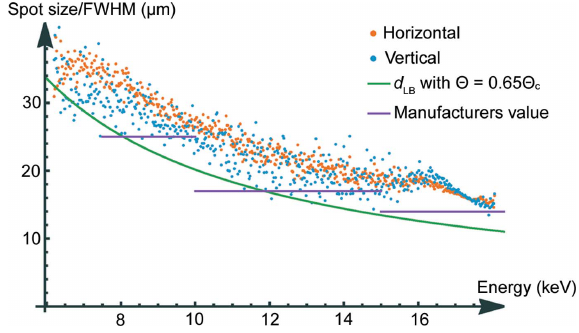
Figure 7 Energy-dependent spot size of PC-246 in the focal distance for horizontal and vertical knife-edge scans.